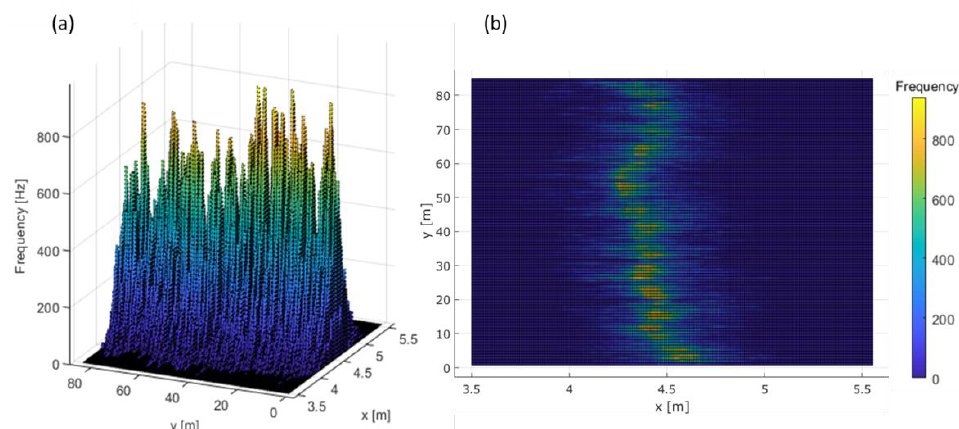
Figure 5. Result of the registration and alignment of one apple row point cloud after merging and filtering. ( a ) Intensity image, where the warmer squares indicate the peaks and ( b ) the bivariate point density histogram of the resulted row point cloud.